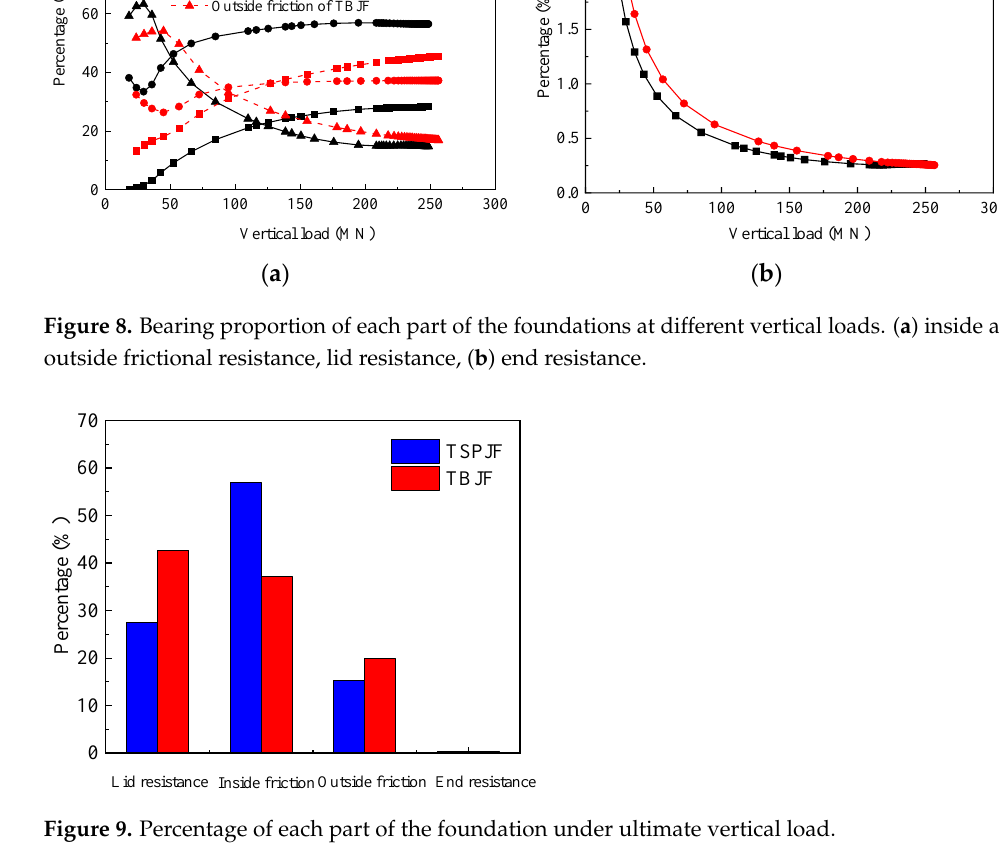
Figure 9. Percentage of each part of the foundation under ultimate vertical load.